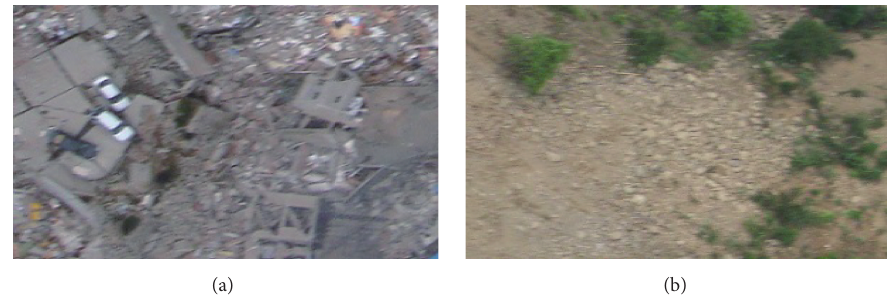
Figure 1: The earthquake images of ground target which are captured by a UVA.